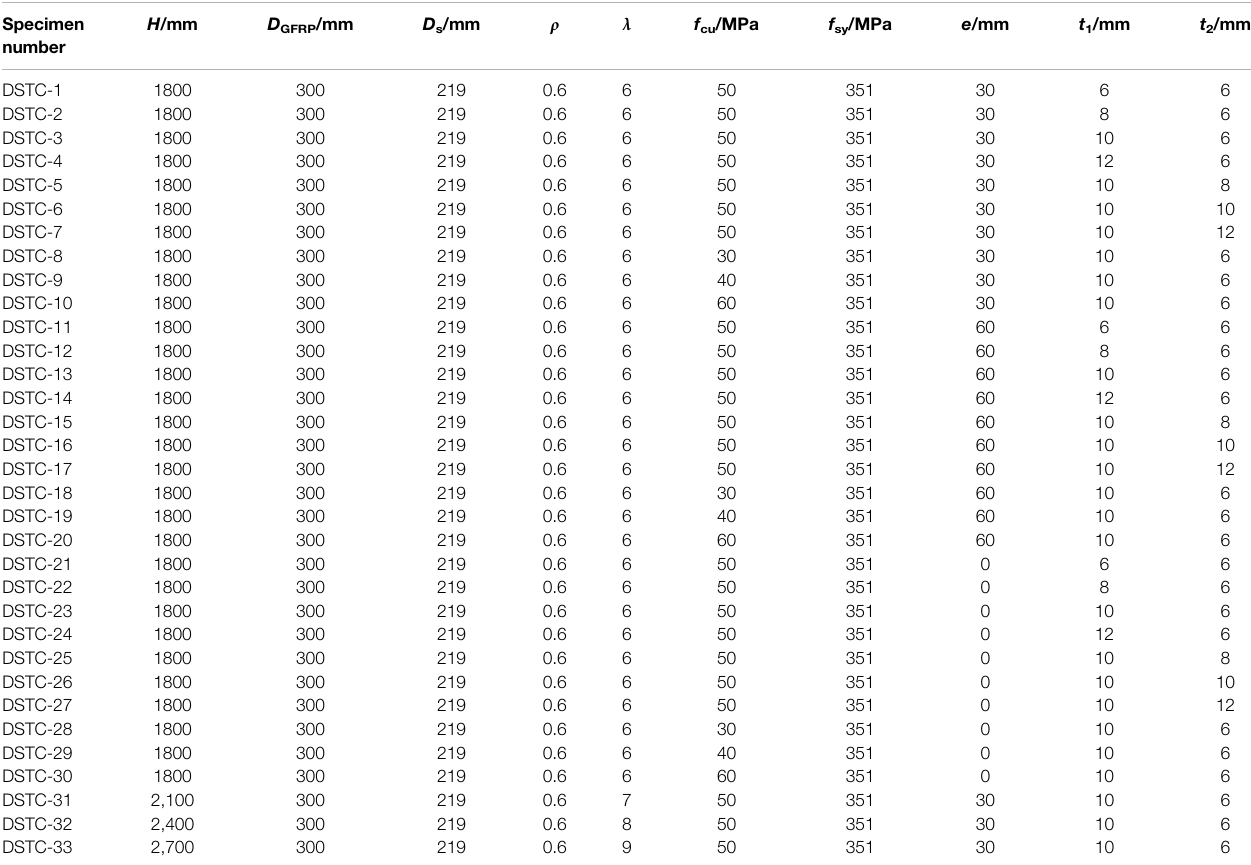
TABLE 1 | Speci fi c parameters of 33 specimens.